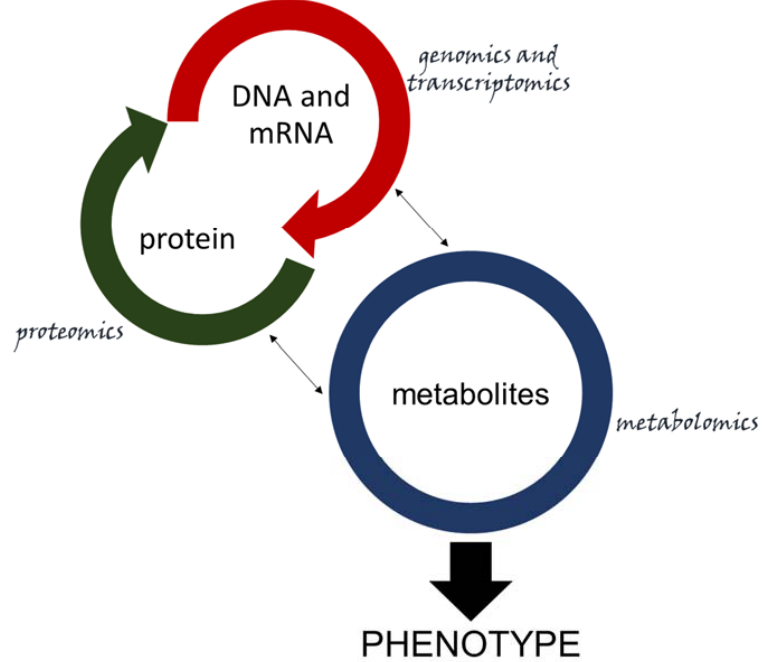
Figure 4. OMICs interaction. DNA and mRNA (red semi-circle) have a direct relationship with proteins (green semi-circle) and can be analyzed by genomics, transcriptomics and proteomics. Though metabolites (blue circle—which are analyzed by metabolomics) do not have a directly obvious relationship with specific genes and proteins, they are related in important ways that ultimately underlie phenotypes. The smaller arrows symbolize that indirect relationship, while the whole system is connected to phenotypes through the large